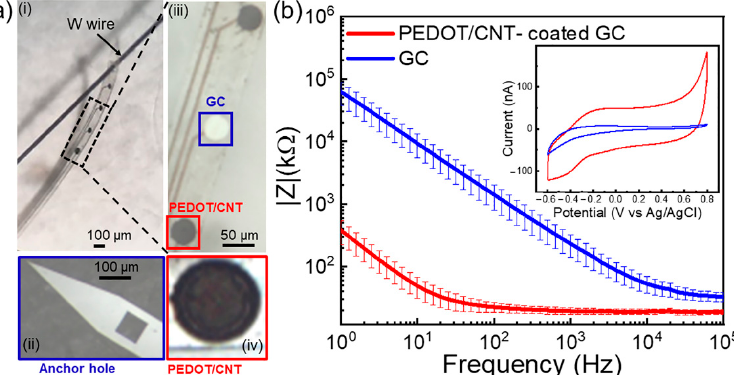
Figure 4. PEDOT/CNT-coated GC MEA. ( a ) ( i ) Optical picture of GC MEA on SU8 substrate with metal interconnection and GC microelectrodes, alternately coated with PEDOT/CNT. This proto-